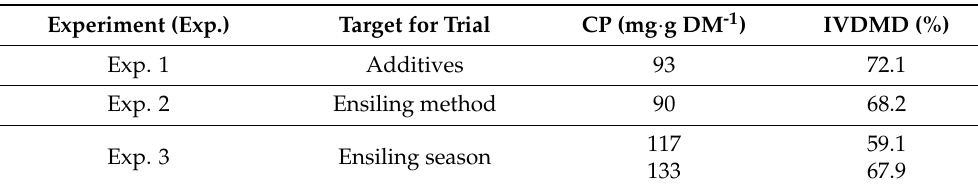
Table 2. Crude protein (CP) concentration and in vitro dry matter digestibility (IVDMD) at ensiling of dwarf Napiergrass (Experiments 1–3).